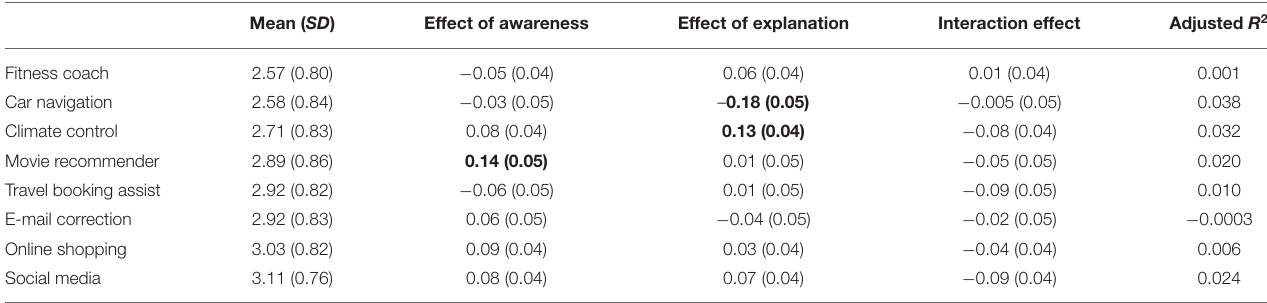
TABLE 7 | The means and standard deviations of reactance and the modeling results (regression coefficients with standard errors and adjusted R 2 ) for each of the eight application scenarios (ranked from low to high in terms of